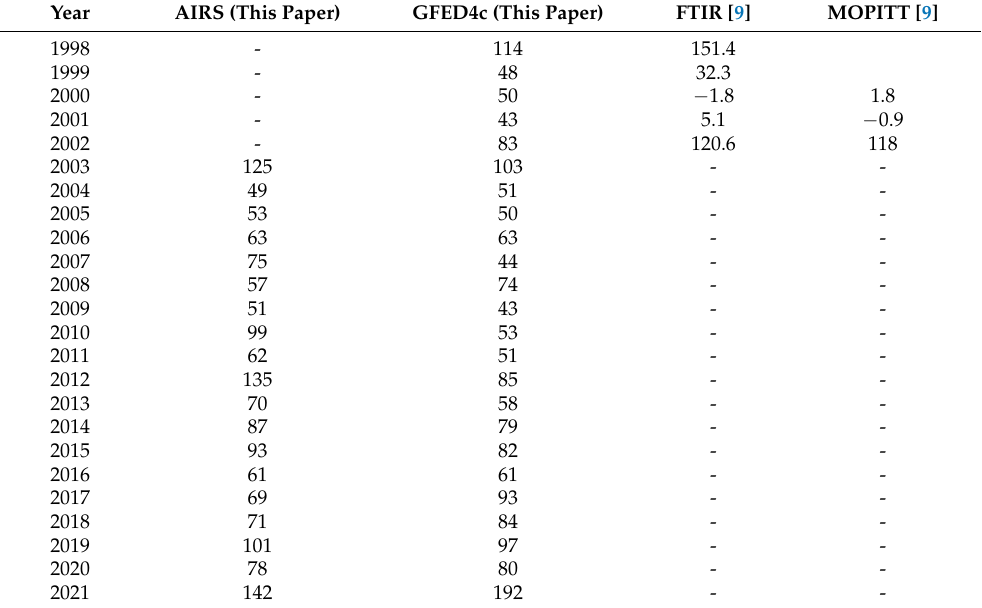
Table 2. Annual HNH CO fire emissions in Tg yr − 1 for this paper and from [9]. FTIR stands for Fourier transform infrared ground-based